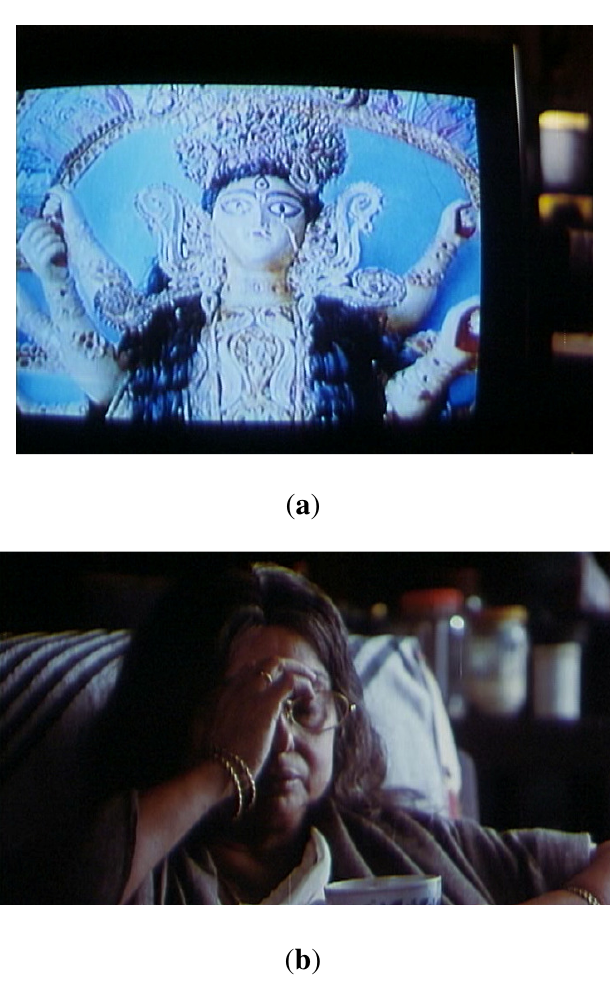
Figure 14. (a) The pratima on the television screen ( b ) Bhagabati salutes Durga; screen grabs, Utsab